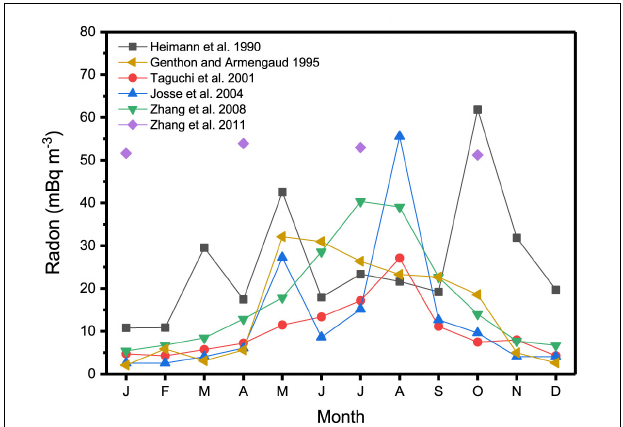
FIGURE 17 | Monthly mean simulated radon concentrations at Dumont d’Urville for various years (see references for details).